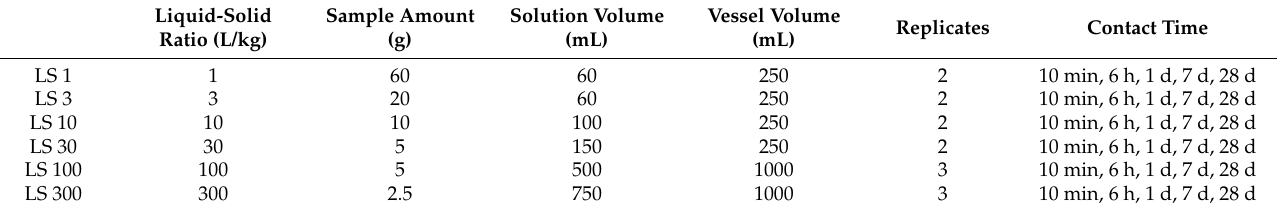
Table 2. Summary of LS-parallel test